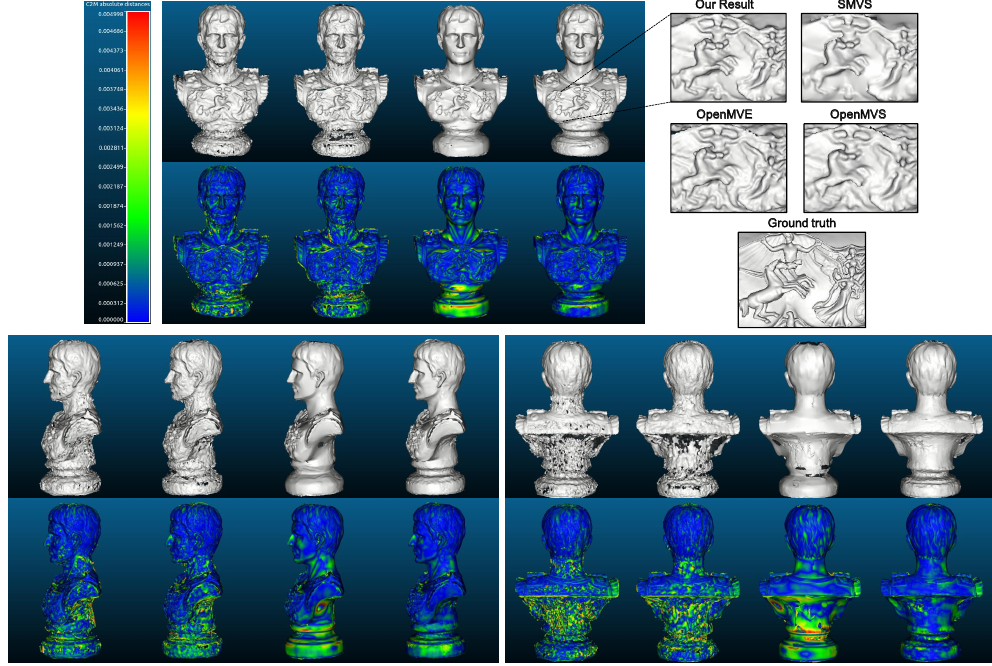
Figure 21. Snapshots of reconstructed models and deviation maps (meter) to the reference model from the front, side and back views. For each view, from left to right are the results of MVS, MVE, SMVS and our approach respectively. It is clear that MVS and MVE generate very uneven and noisy geometry, while SMVS based on global optimization produces a smooth but distorted